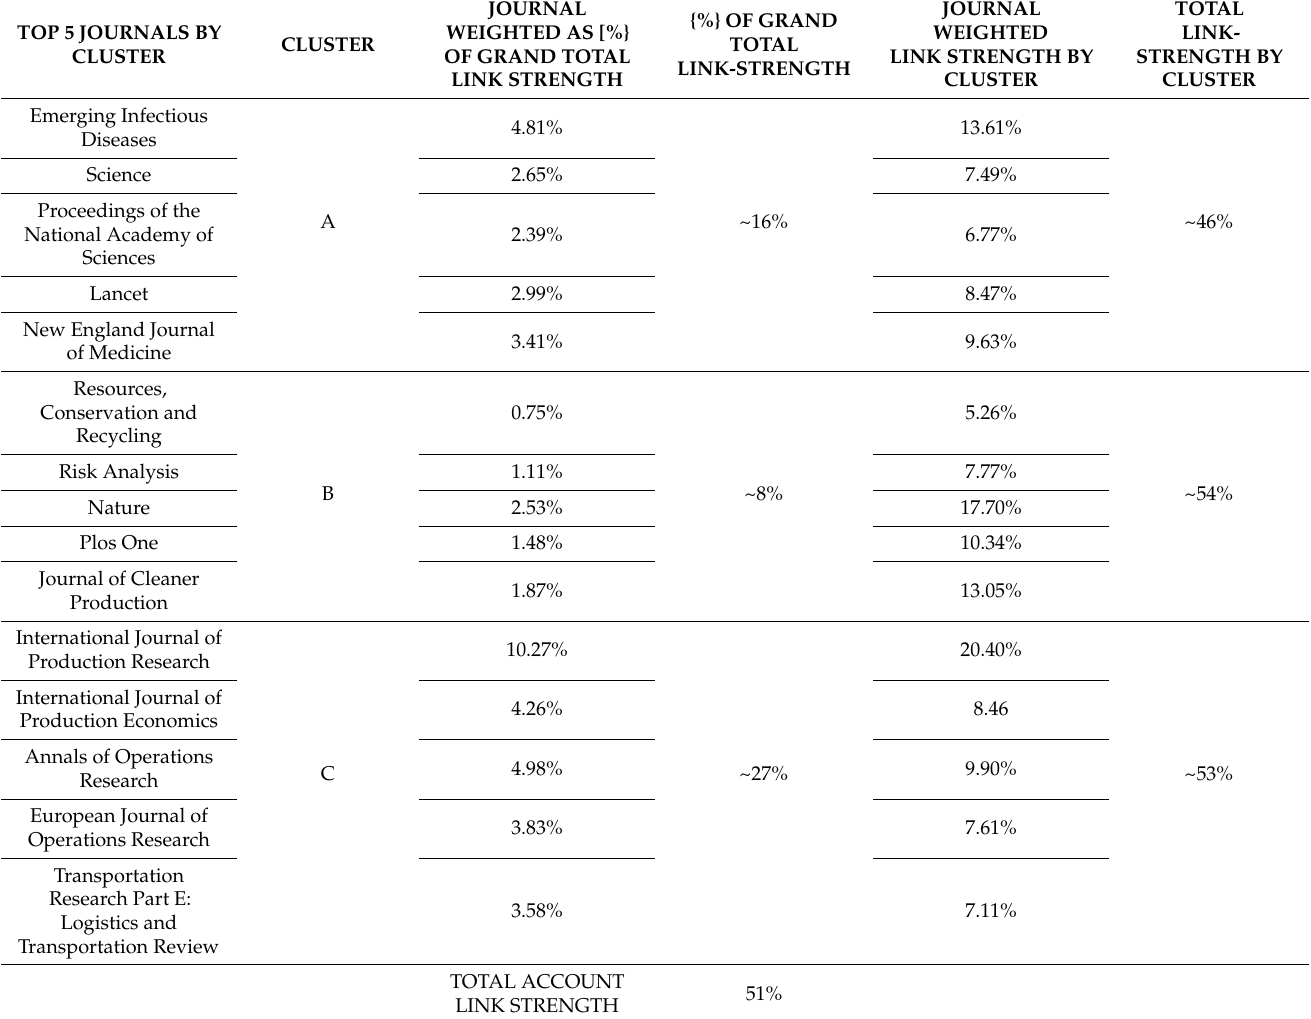
Table 10. Cluster Analysis Link